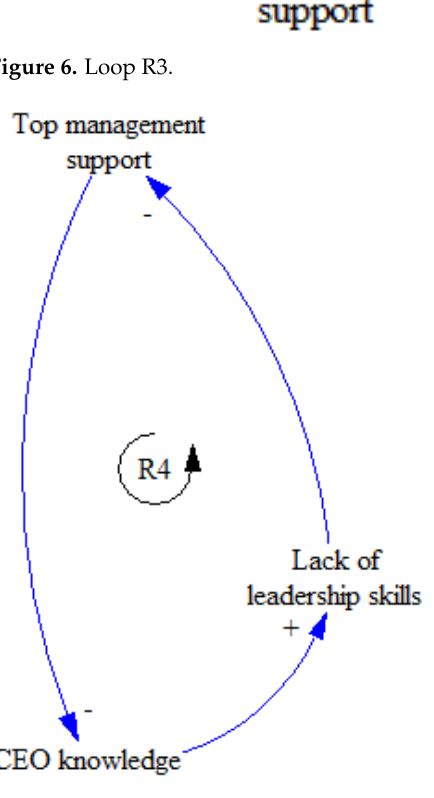
Figure 7. Loop Figure 7. Loop R4.